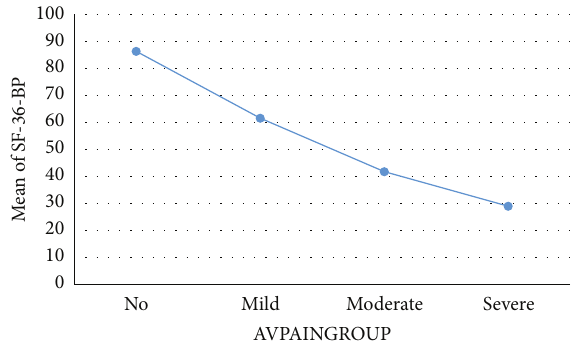
Figure 1: Mean SF-36 bodily pain (BP) in ulcerative colitis accord- ingtoaveragepainseverity.SF-36:short-Form36.AVPAINGROUP: average pain grouped according to cut-off values 0 = no, 1–3 mild, 4–6 moderate, and ≥ 7 severe. Mean bodily pain scored from 0 to 100. A higher score indicates less